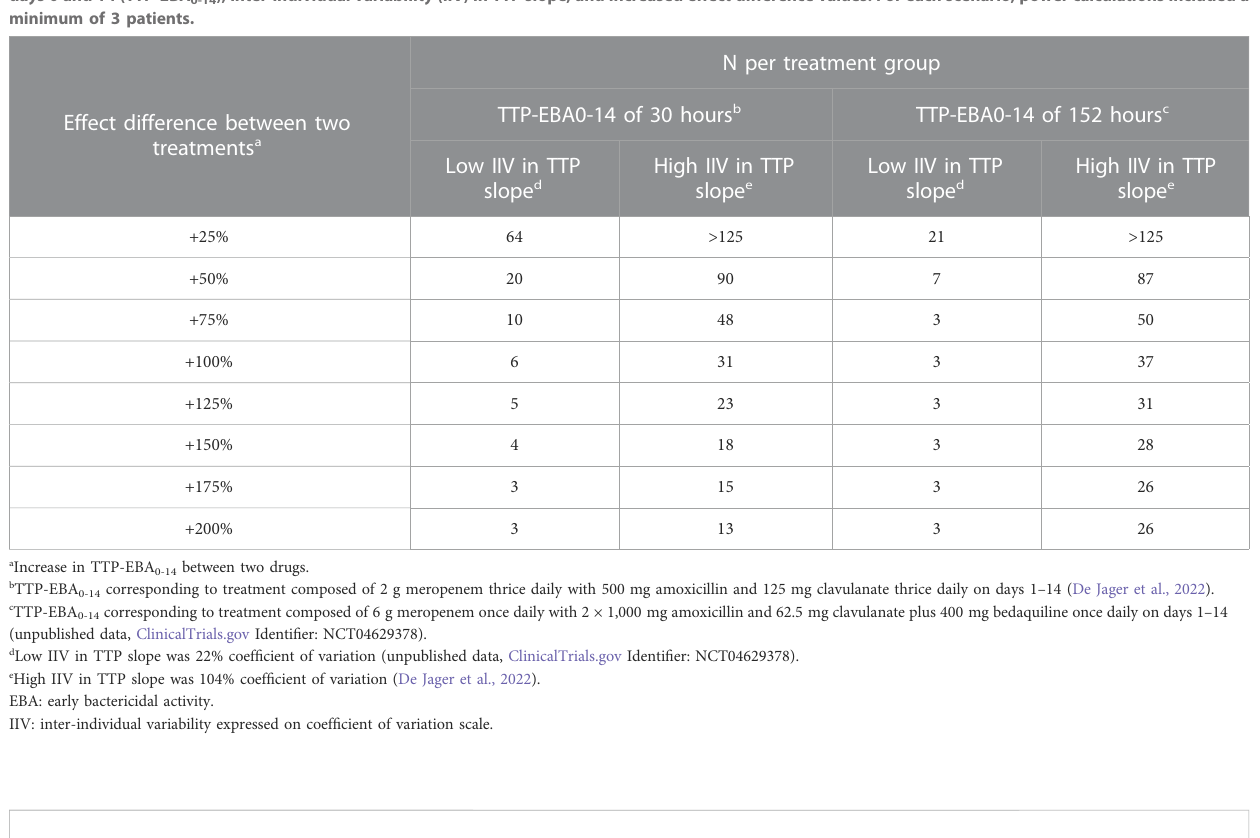
TABLE 2 Sample size per group in an early bactericidal activity (EBA) clinical trial needed to detect an effect difference between two treatment groups with 80% powerata5%signi fi cancelevel.Powercalculationswereperformedusingamono-exponentialtime-to-positivity(TTP)modelfordifferentchangeinTTPbetween days 0 and 14 (TTP-EBA 0-14 ), inter-individual variability (IIV) in TTP slope, and increased effect difference values. For each scenario, power calculations included a minimum of 3 patients.